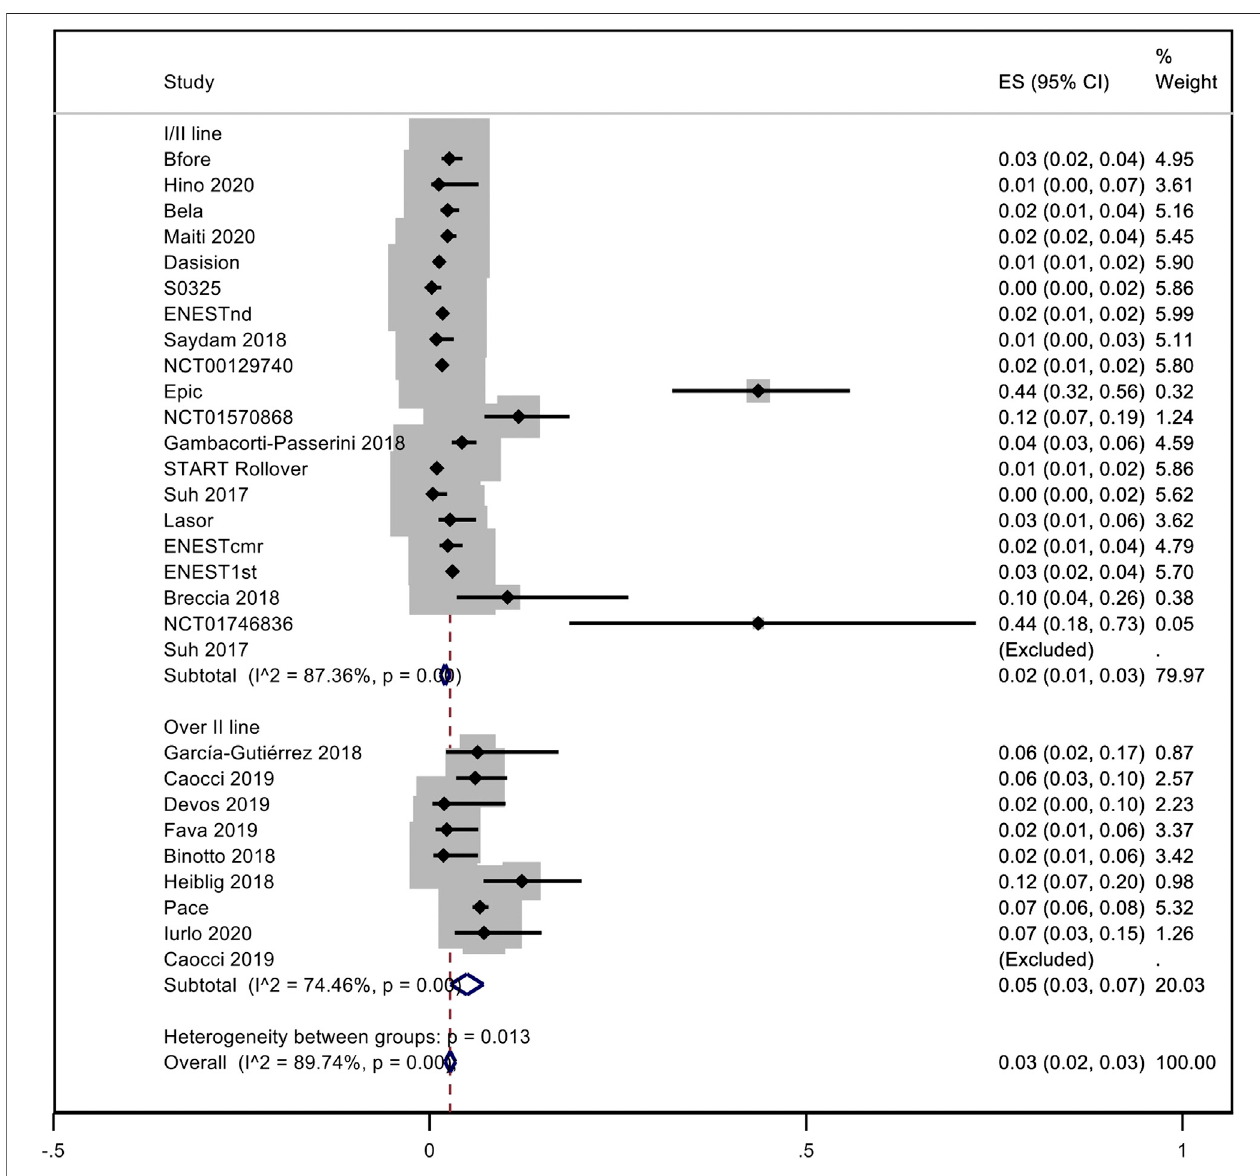
FIGURE 3 | Pooled rate of hypertension when TKI were used in the fi rst- or second-line versus over second-line.